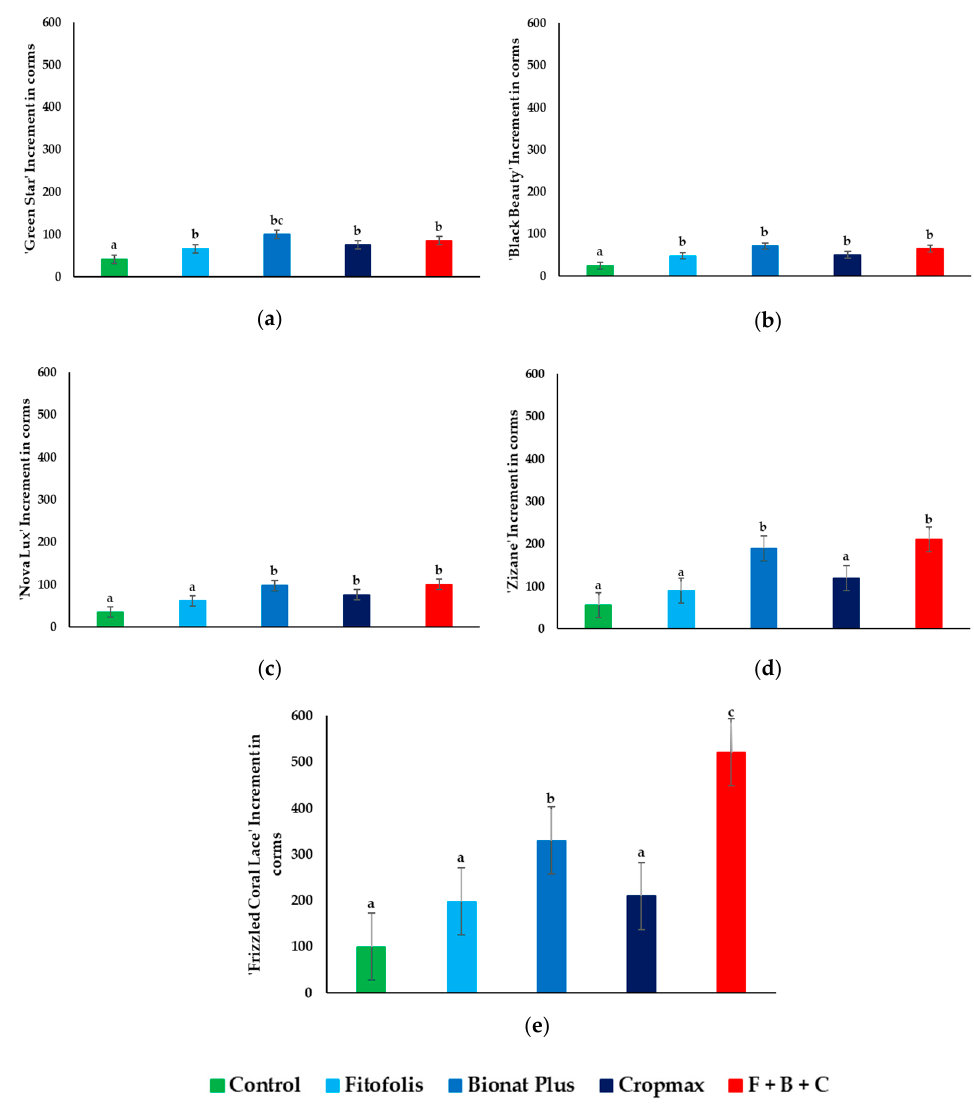
Figure 4. Effect of foliar fertilization on increment in daughter corms in Gladiolus varieties: ‘Green Star’ ( a ), ‘Black Beauty’ ( b ), ‘Nova Lux’ ( c ), ‘Zizane’ ( d ), and ‘Frizzled Coral Lace’ ( e ). Increase in daughter corms under control conditions and in the presence of the indicated foliar fertilization: Fitofolis, Bionat Plus, Cropmax and the mixture of Fitofolis–Bionat Plus–Cropmax (F + B + C). Bars represent the means ± SE ( n = 10). Different letters above the bars indicate significant differences between the treatments, according to Tukey test ( α = 0.05).